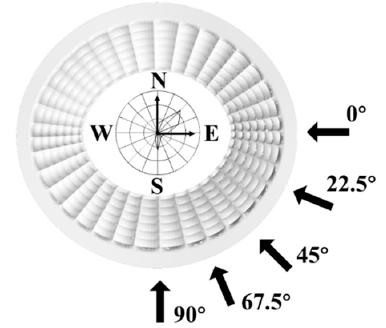
Figure 8. Study cases conducted for different inflow directions at 22.5° intervals (0°, 22.5°, 45°, 67.5°, and 90°).